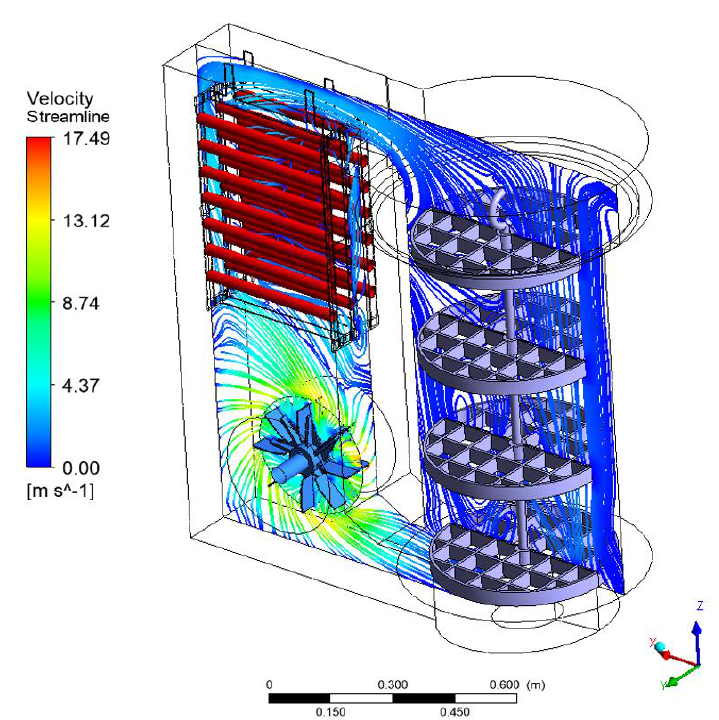
Figure 12. Streamlines inside the furnace for baseline operation with a charging basket. The velocity streamline legend applies to the recirculating gases.